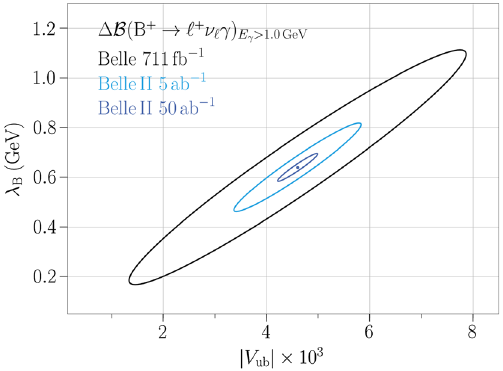
Fig. 3 Projection of the extraction of λ B and | V ub | for the expected Belle II data sets. The ellipses correspond to the expected uncertainty. The figure is from Ref.